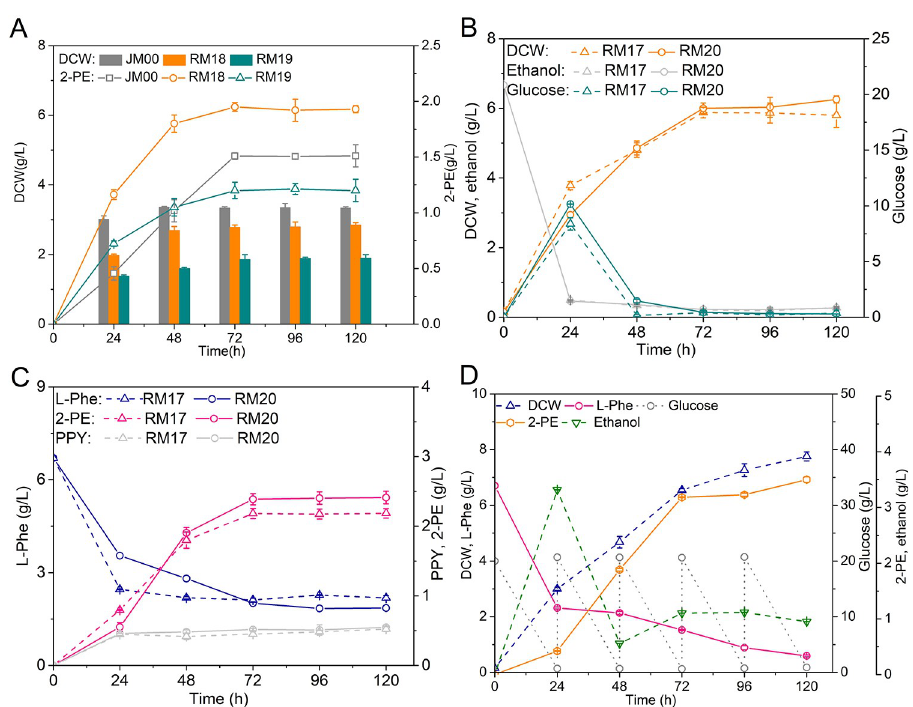
Fig 6. The new expression module of lgox for 2-PE synthesis in Ehrlich pathway. (A) Influence on cell growth and 2-PE production by L-glutamate oxidase expressing mutant strains. (B) Cell growth, ethanol and glucose consumption of RM17 (WT-A P TPI -ectyrB-llkdcA-scADH2 ) and RM20 (WT-A P TPI -ectyrB-llkdcA-scADH2 P TPI -strlgox ) in YSM medium. (C) Improvement of 2-PE synthesis and L-phenylalanine consumption in RM20 compared to RM17 in YSM medium. (D) Fermentation view of RM20 in YSM medium with the addition of 20 g/L glucose every 24 h. Data are presented as the averages of the results of three independent experiments. Error bars show standard deviations.